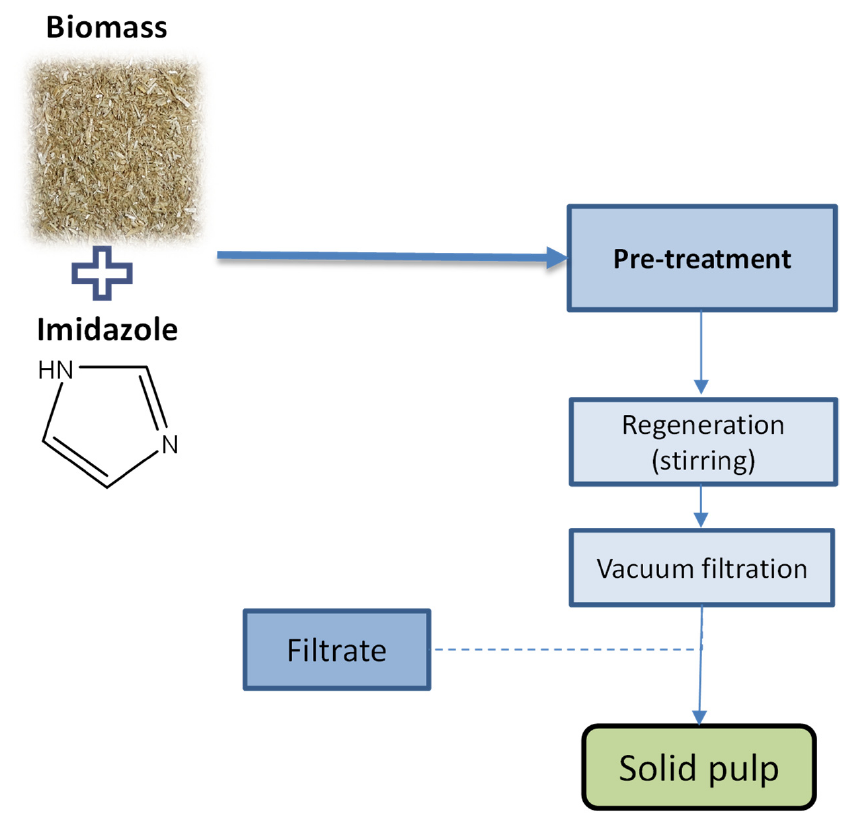
Figure 1. The procedure of biomass pre-treatment with imidazole.